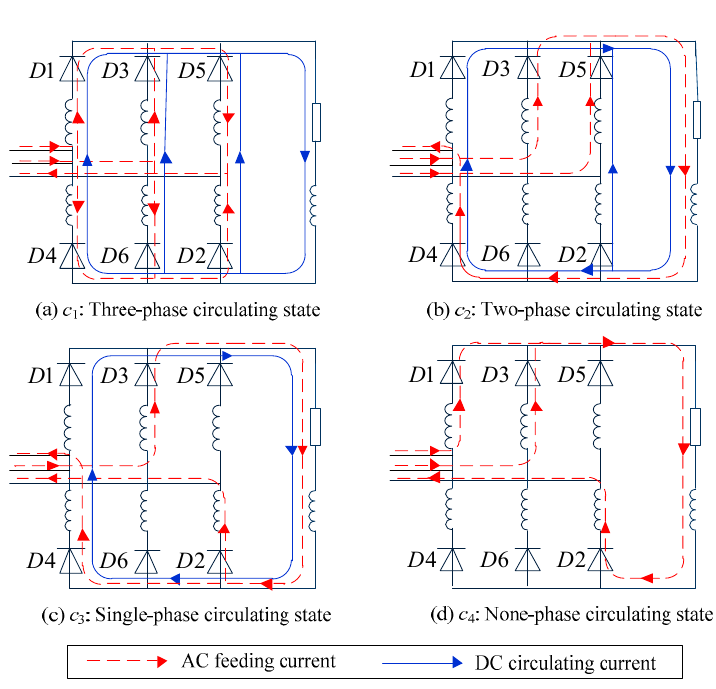
Figure 7. Current loops of critical states.